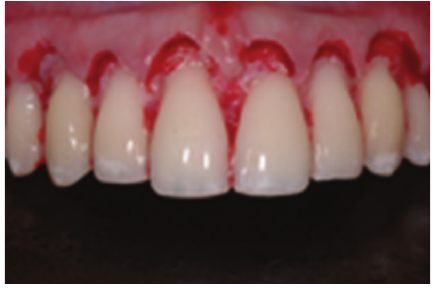
Figure 11: After osseous resective surgery.